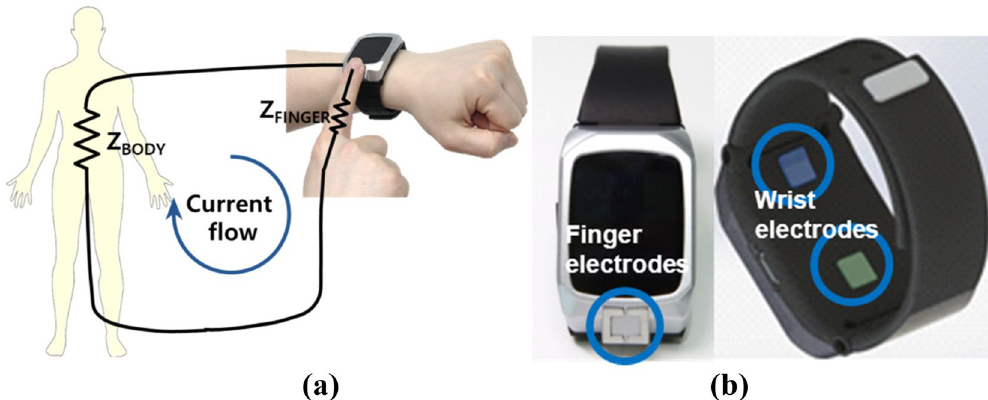
Figure 1. Bioelectrical impedance measurement using ( a ) single-finger and ( b ) watch-type BIA devices. The positions of 4 electrodes are shown (one pair for the finger on the top side and the other pair for the wrist on the bottom side of the main body of the